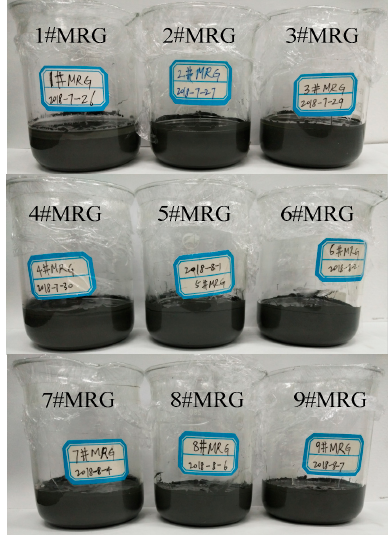
Figure 2. Appearance of MR greases after holding in a static state for 30 days.